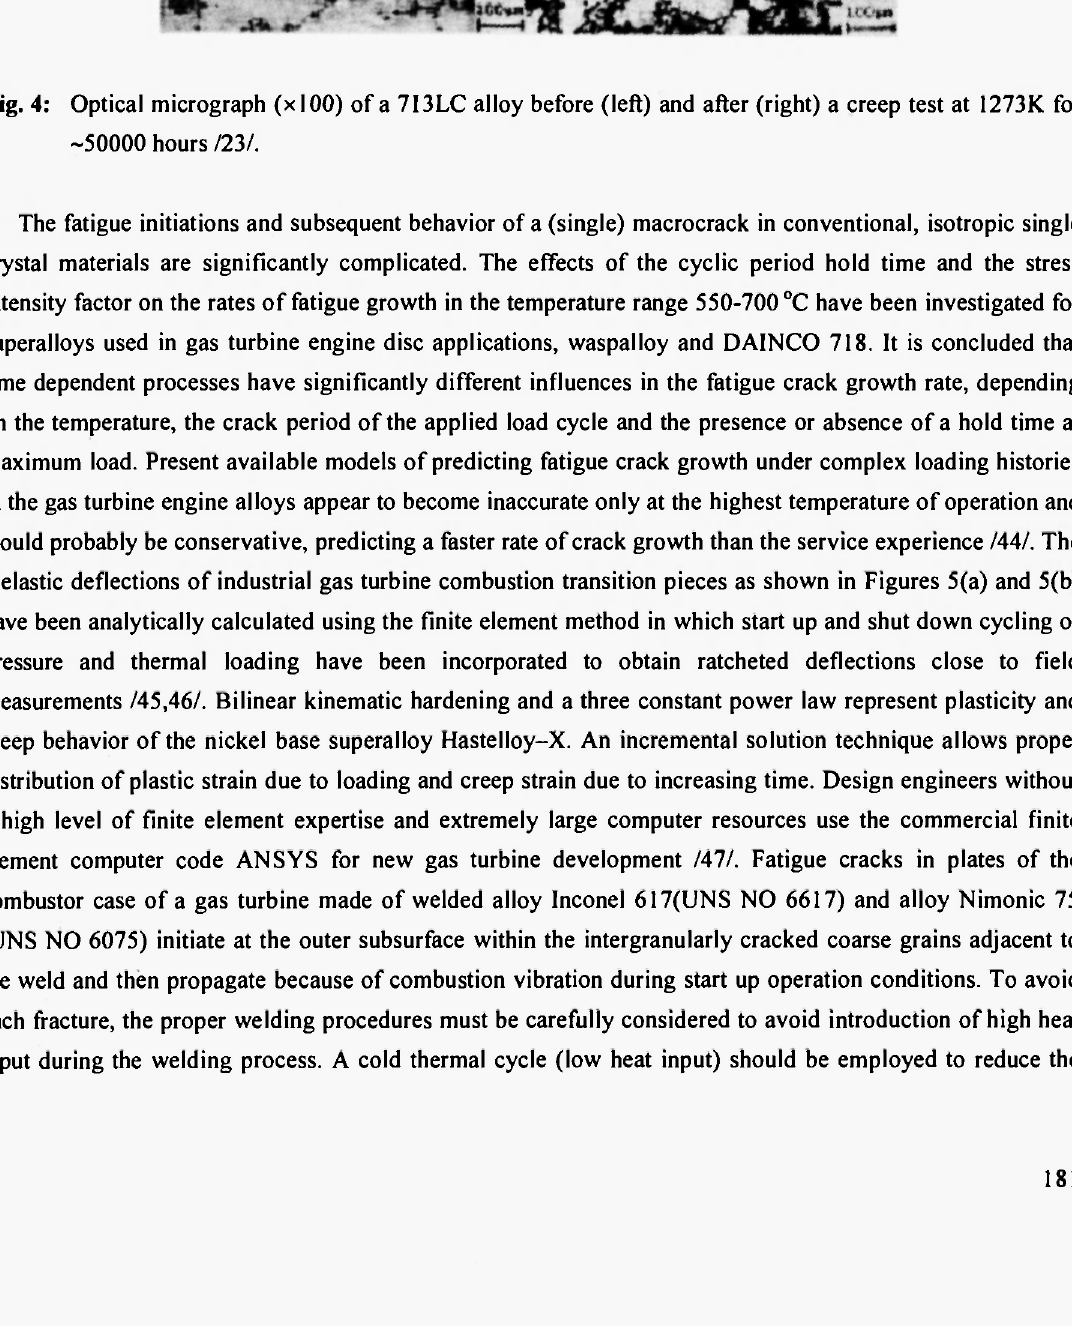
Fig. 4: Optical micrograph (xlOO) of a 7I3LC alloy before (left) and after (right) a creep test at 1273K for -50000 hours